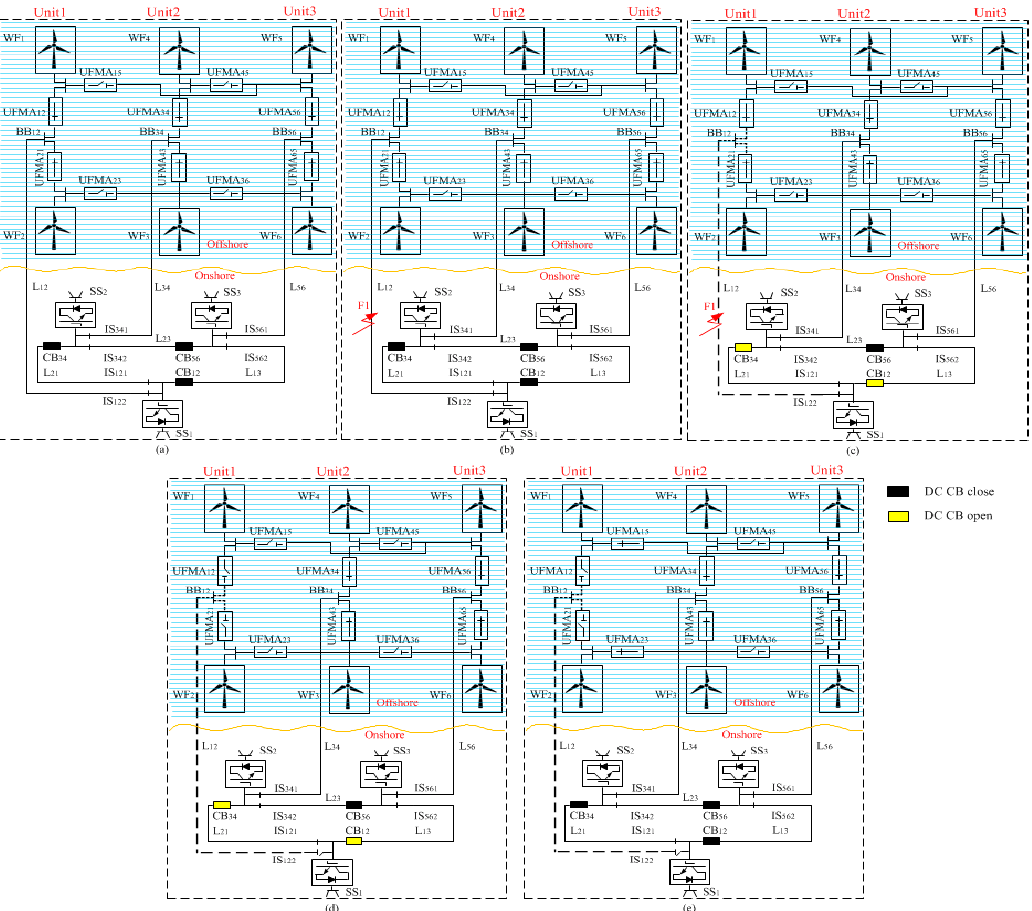
Figure 7. 2WF-SSRT topology operation in the event of a fault on the line L 12 : ( a ) at t 0 , 2WF-1SST topology during normal operation, ( b ) at t 1 , fault appears on the line L 12 , ( c ) at t 2 , CB 12 and CB 34 operates, ( d ) at t 3 , IS1 22 , UFMA 12 , and UFMA 21 open ( e ) at t 4 , first UFMA 15 and UFMA 23 are closed and then CB 12 and CB 34 re-closed as